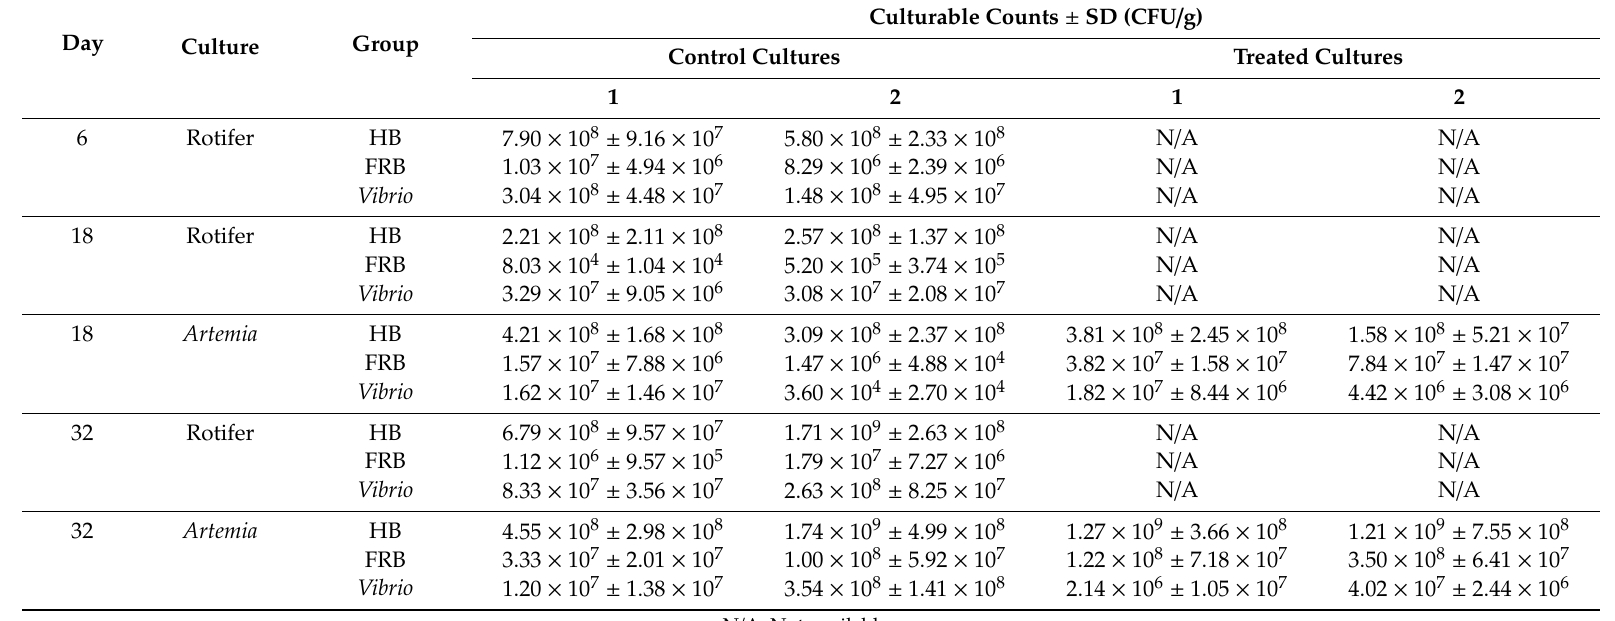
Table 1. Heterotrophic bacteria (HB), florfenicol-resistant bacteria (FRB), and Vibrio spp. in mass live-feed cultures used for rearing G. chilensis